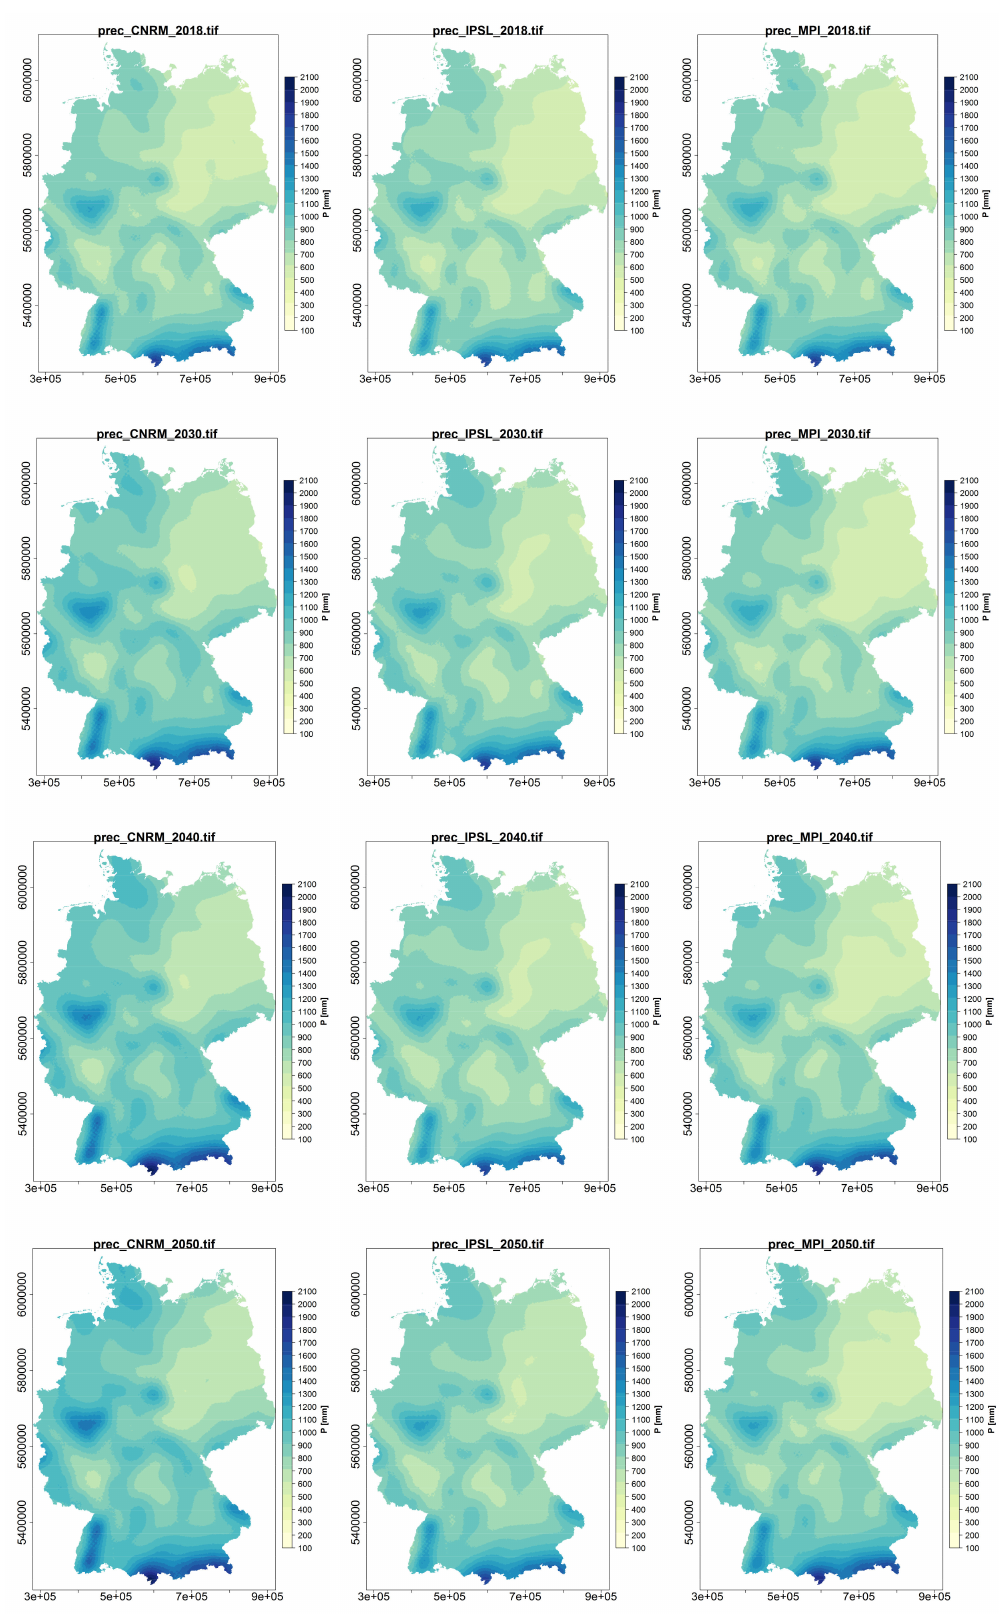
Figure 9. Precipitation [mm] for three different climate projections for four time periods (dark color means high, light color means low). For the interpretation of the numbers on the X axis, 5400000 = 54,000.00, 5600000 = 56,000.00, 5800000 = 58,000.00, 6000000 =